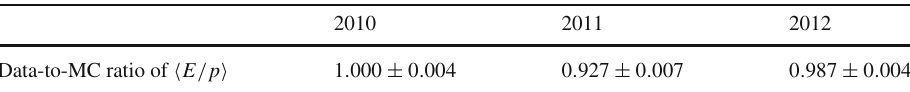
Table 10 Double ratios (cid:4) E / p (cid:5) / (cid:4) E / p (cid:5) data MC with their statistical uncertainties for years 2010 to